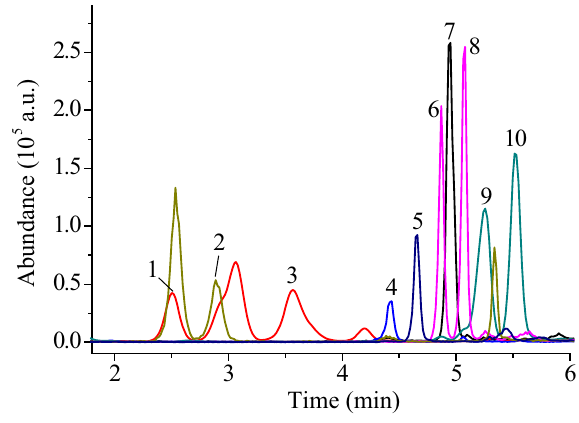
Fig. 2 The extracted ion chromatogram (EIC) of ten steroid deriva- tives at the concentration of 50 ng mL −1 . 1—21-deoxycortisol derivative; 2—cortisone derivative; 3—corticosterone derivative; 4—estrone derivative; 5—progesterone derivative; 6—dehydroepian- drosterone derivative; 7—4-androstenedione derivative; 8—testoster- one derivative; 9—dihydrotestosterone derivative;10—androsterone